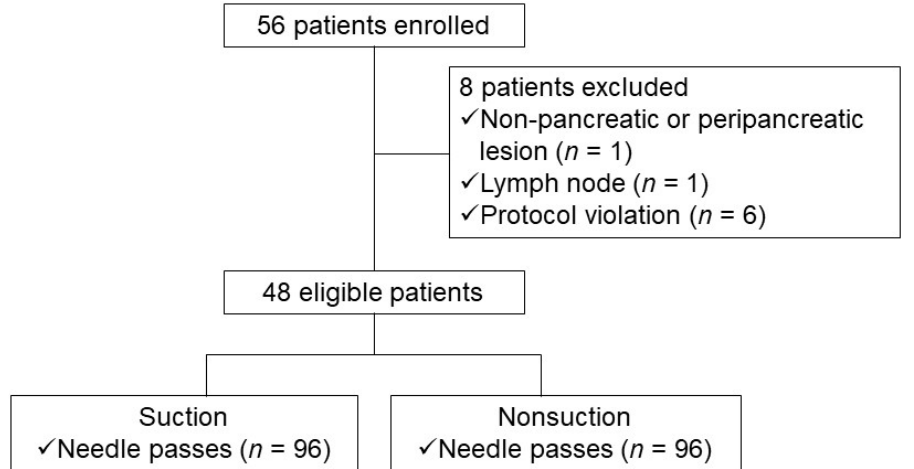
Figure 2. Study flow chart depicting patient selection (study II). A total of 184 needle passes were performed in 46 patients, such that 92 needle passes were done alternatively by using the S or CSSS method (Table 5). The cytologic adequacy rate of the specimen was significantly higher with suction than without suction (93% vs. 81%, p = 0.02, Table 6). The cellularity and blood contamination of specimen were also higher with suction than without suction (40% vs. 24%, p = 0.02; 39% vs. 19%, p < 0.01, respectively). No difference in the diagnostic yield of malignancy was seen in the suction and non-suction groups (87% vs. 80%, p = 0.15). Table 5. Baseline characteristics of enrolled patients in a head-to-head comparison study between suction and non-suction (study